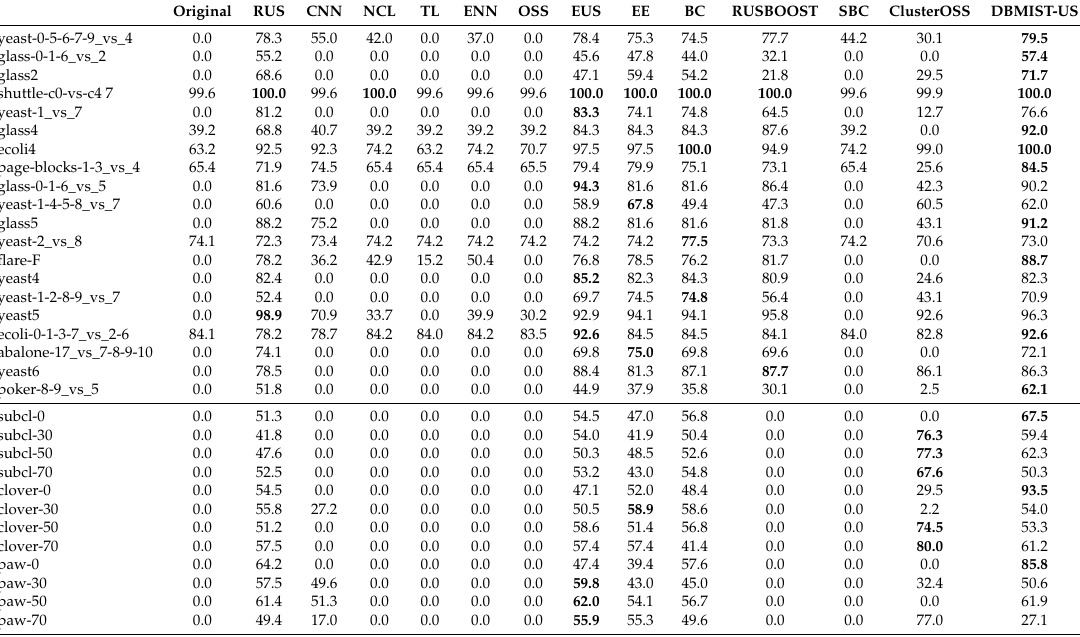
Table A3. Geometric mean results obtained with